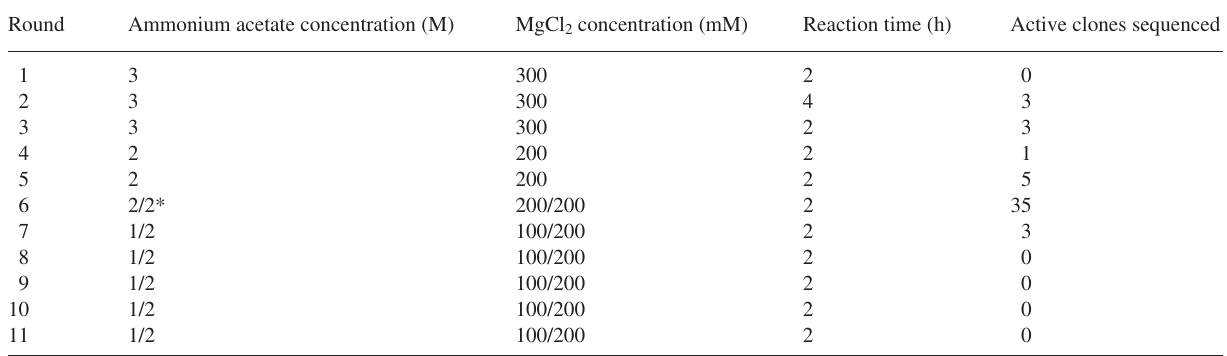
* Rounds 6–11 were performed